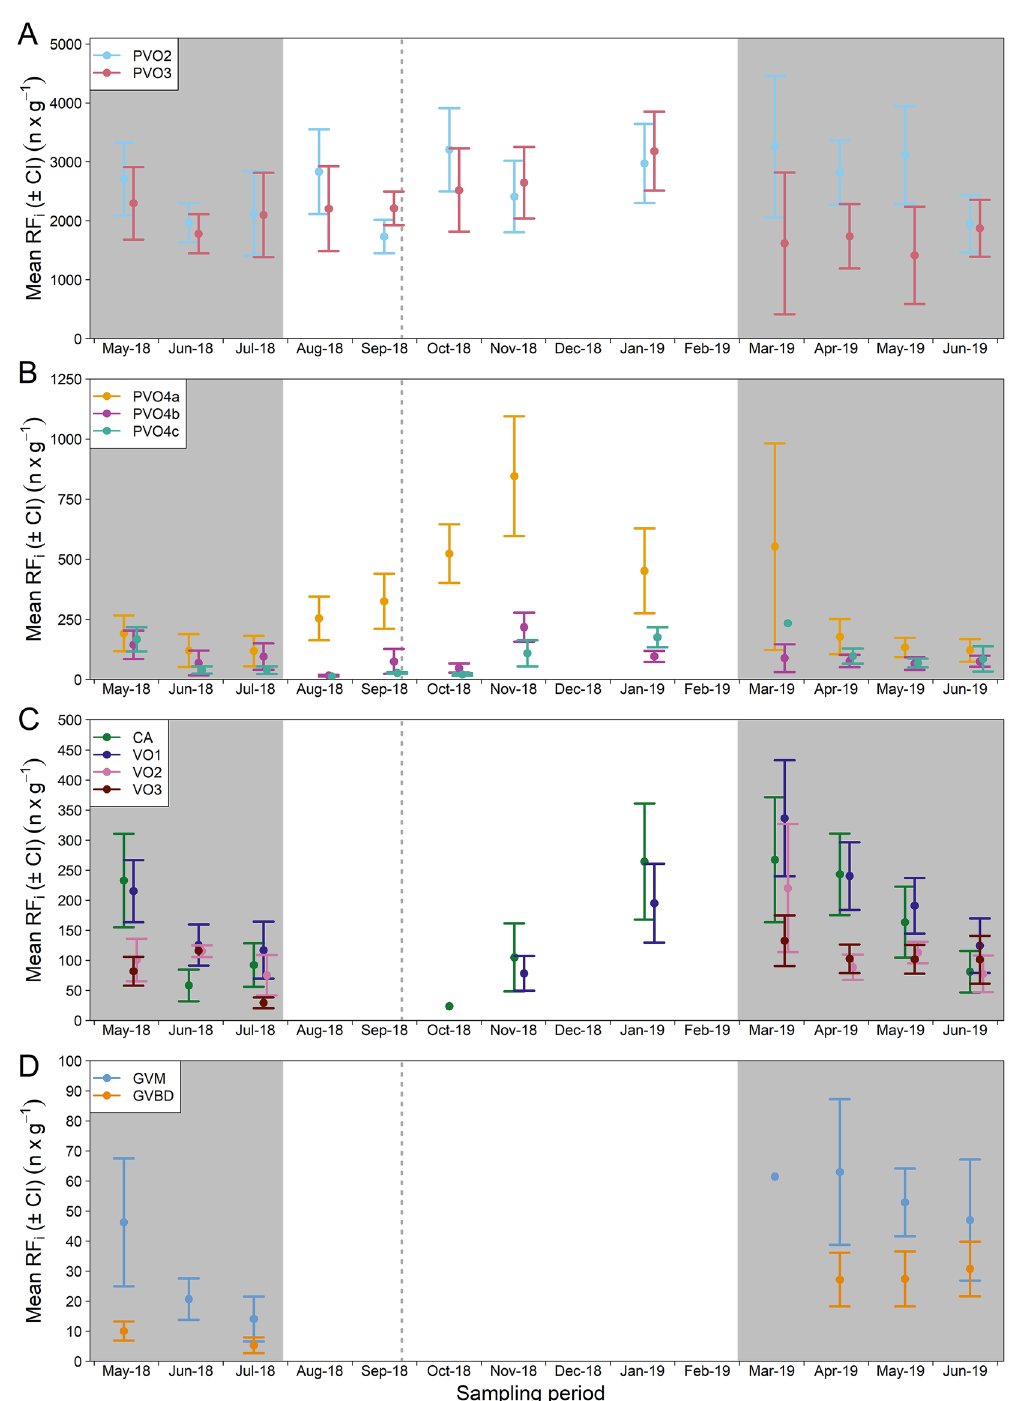
Figure 6. Monthly variation (mean and ± 95% confidence interval) in phase i -specific oocyte relative fecundity (RF i ). ( A ) Monthly variation in RF i of small previtellogenic oocytes (PVO2 and PVO3); ( B ) large previtellogenic oocytes (PVO4a–c), ( C ) cortical alveoli oocytes (CA), vitellogenic oocytes (VO1-3), and ( D ) oocytes in final maturation (germinal vesicle migration [GVM] and germinal vesicle breakdown [GVBD]). The autumn equinox is indicated (vertical dashed line). Grey bands indicate the spawning season. Note that the y-axis scale differs between panels. No samples were collected in December-18 and